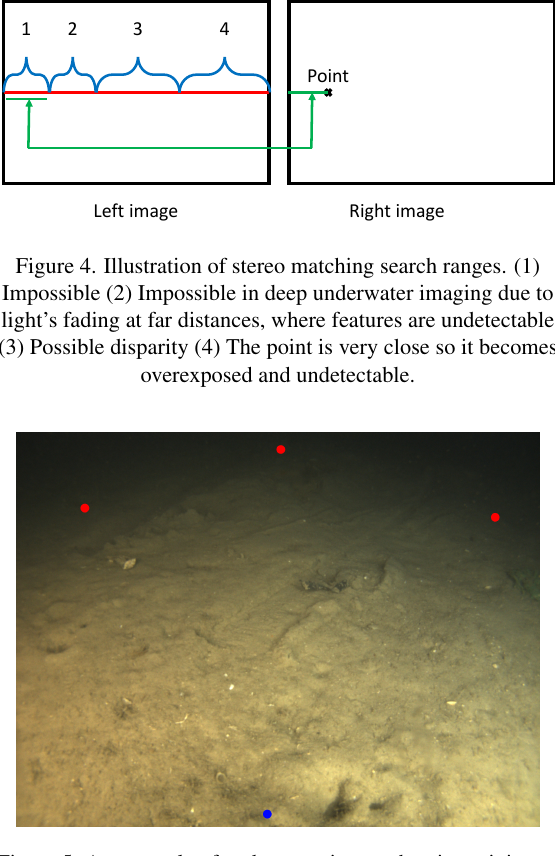
Figure 5. An example of underwater image showing minimum possible disparity (red dots, ∼ 140 pixels) and maximum possible disparity (blue dot, ∼ 430